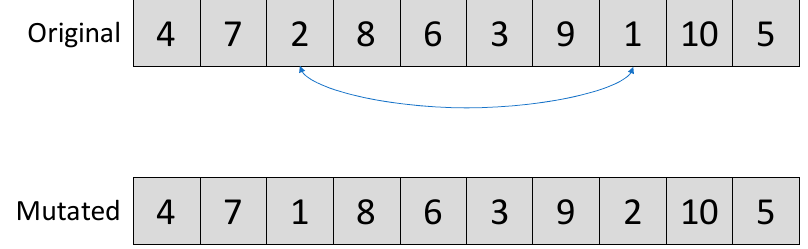
Figure 6. Switch mutation.